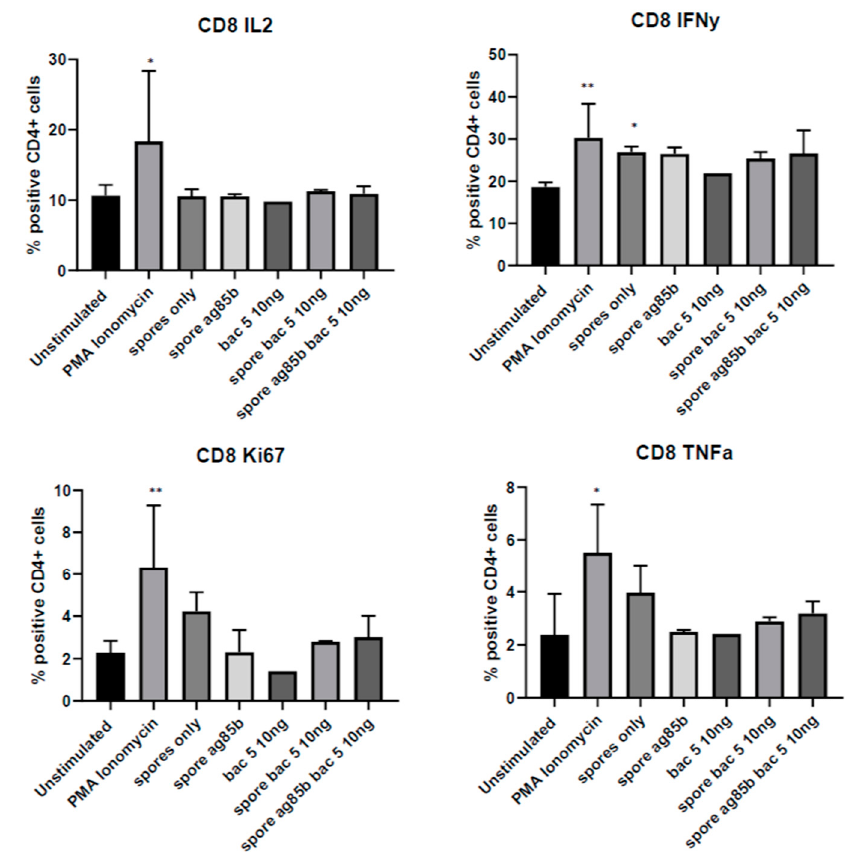
Figure 5. Intracellular Cytokine Production and Proliferation of Stimulated CD8 + Tonsil Mononuclear Cells. Human tonsil mononuclear cells were prepared as described and stimulated with different adjuvant combinations including B. subtilis spores (at a ratio of 100:1 to tonsil cells); Ag85B (5 µg/mL) and/or a titration of Bac5 peptide. PMA ionomycin was used as a positive control. Cells were permeabilised with 0.5% saponin and intracellular cytokines stained using directly labeled target-specific IgG antibody. Fluorescence intensity was established on viable cells using flow cytometry. The percentage of CD8 + cells colocalising with positive fluorescence from either IL-2 + , IFN γ + , Ki67 + or TNF α + positive populations are displayed. Statistical analysis was performed using one-way ANOVA ( ** = p < 0.01, * = p < 0.1).